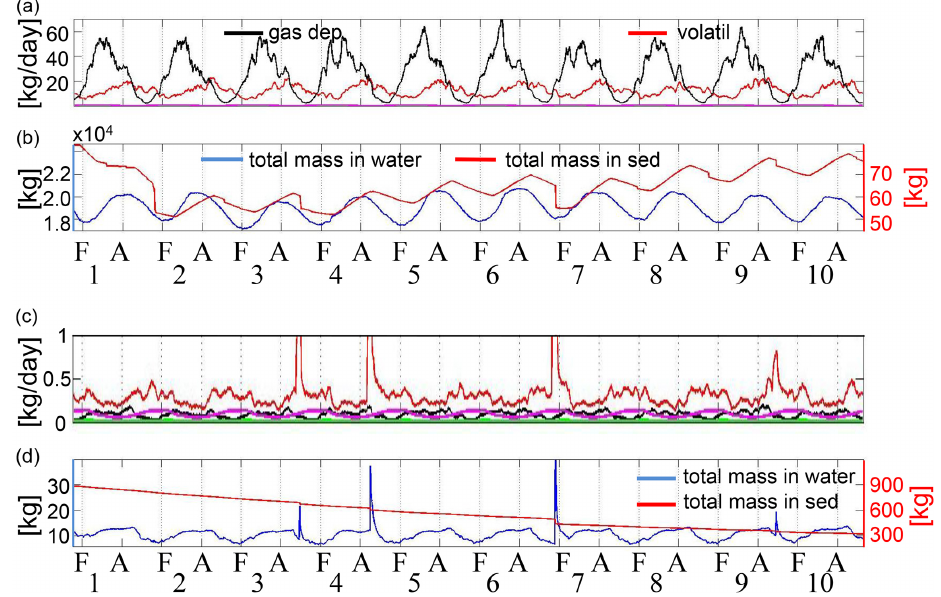
Figure 5. As Fig. 3. but for 2090–2099. Note the different scales (on the left and right) in second and bottom panels showing the different amounts of the substance in water and